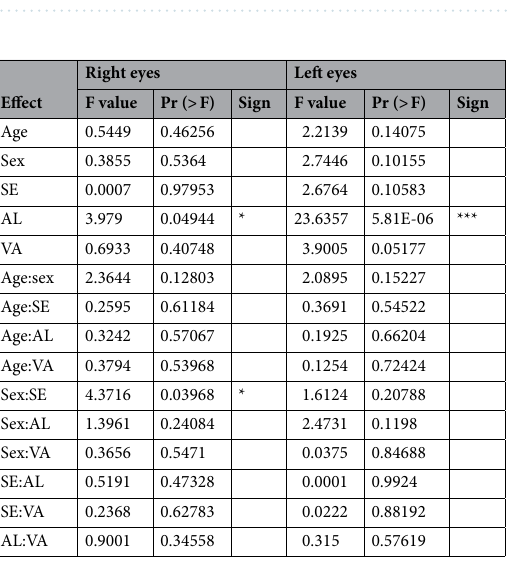
Figure 1. Univariate box plots and scatter plots. Plots in the first row are based on data from the left eyes (OS). Plots in the second row are based on data from the right eyes (OD). Boxplots are grouped by sex. Scatter plots are drawn for age, spherical equivalent, axial length, and visual acuity. Males (females) are indicated by squares (triangles) in the scatter plots. Optical coherence tomography angiography retinal vessel surface area measurements are in mm 2 .